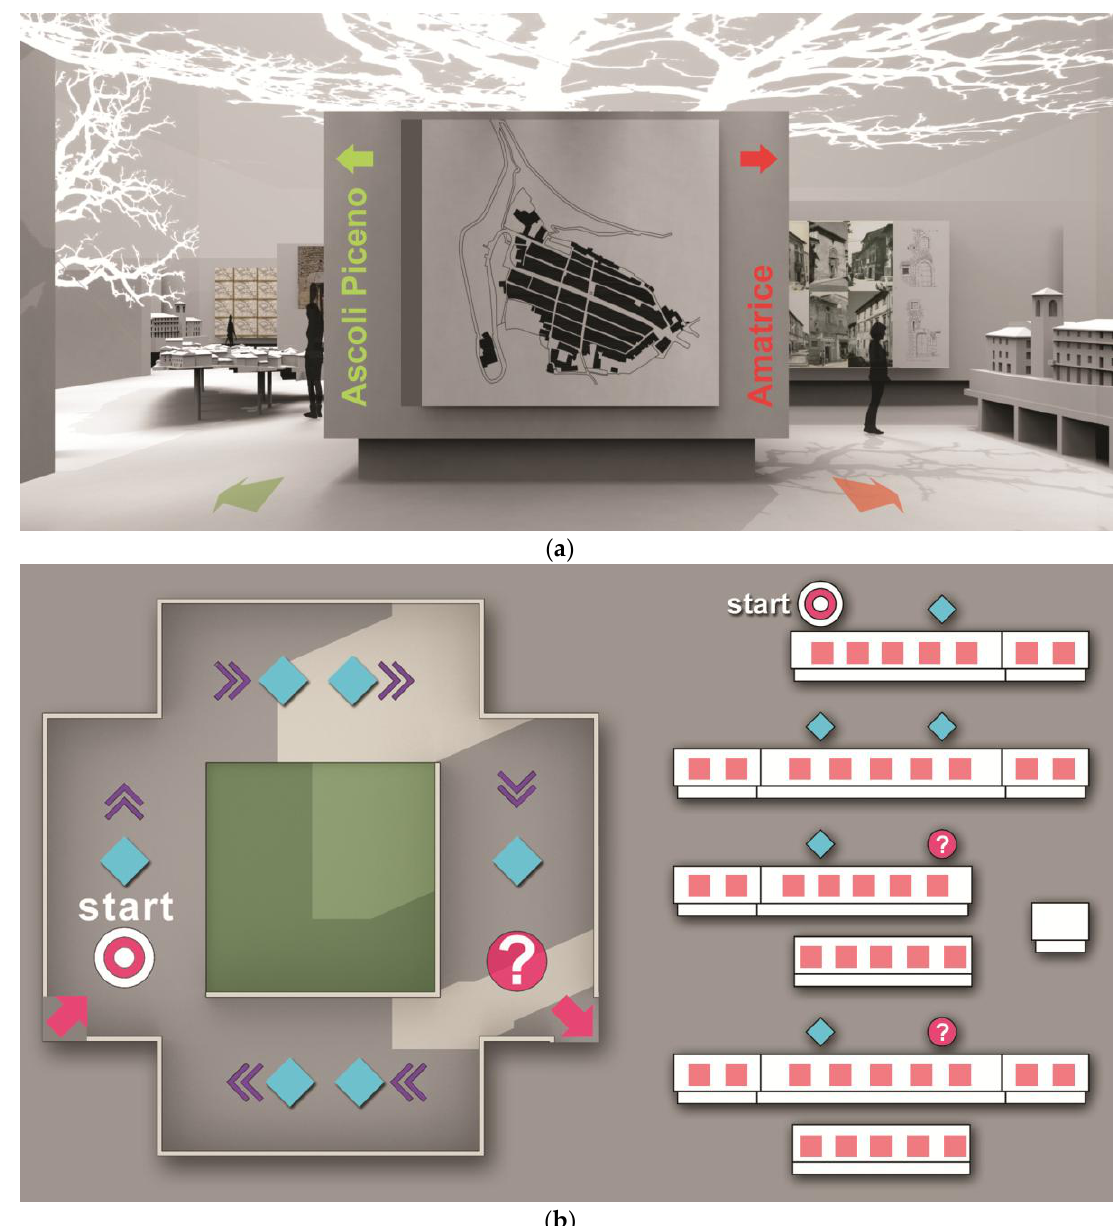
Figure 5. ( a ) The moment when you choose whether to continue the narration chosen or move to a new narration; ( b ) Interface dedicated to the curator. To the left, the plan view in which set up the 3D elements. To the right, the development of the interior elevations where you set up the two- dimensional